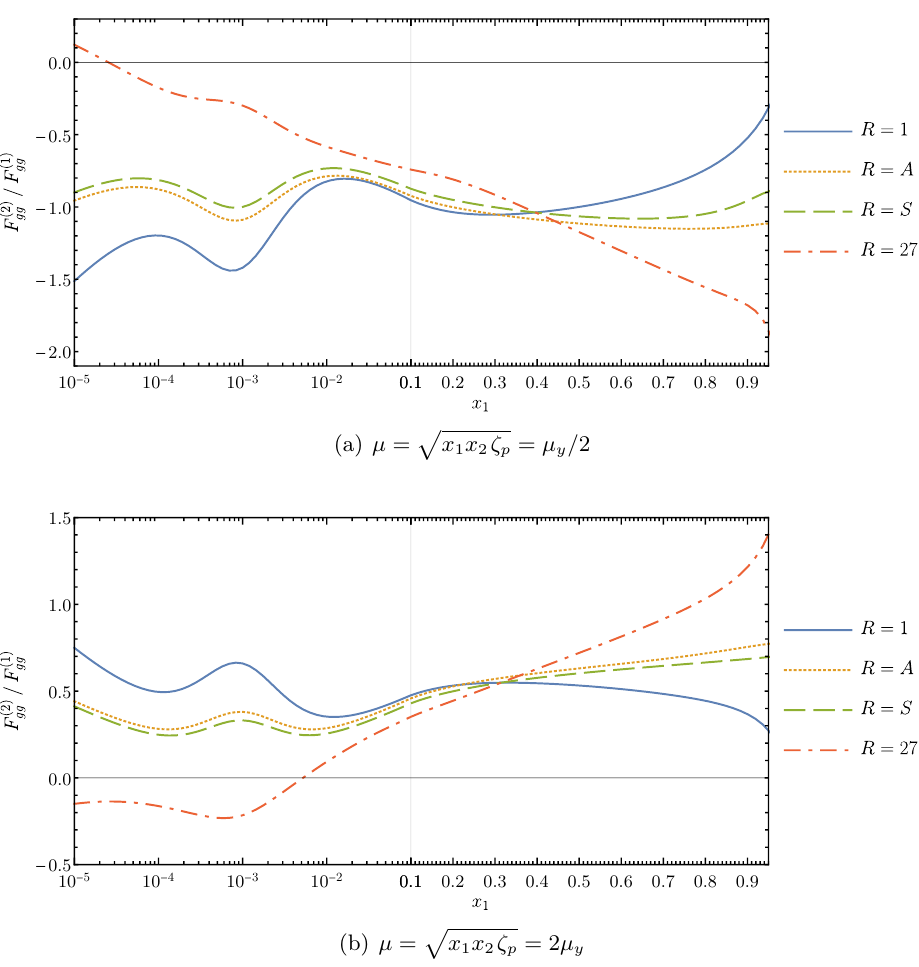
(cid:14) F (1) gg for x 2 = 10 − 3 , evaluated at different values of µ =